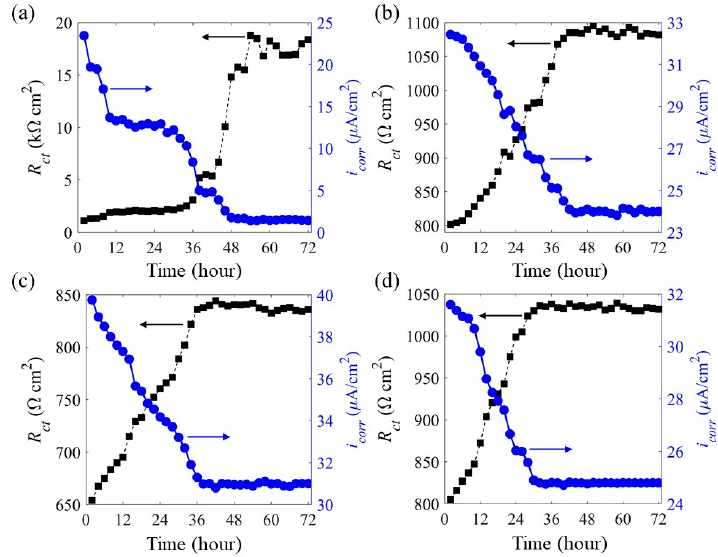
Figure 13. Charge transfer resistance and corrosion current density of the Fe-C layer at ( a ) 0, ( b ) 500, ( c ) 1000 and ( d ) 1500 µε .